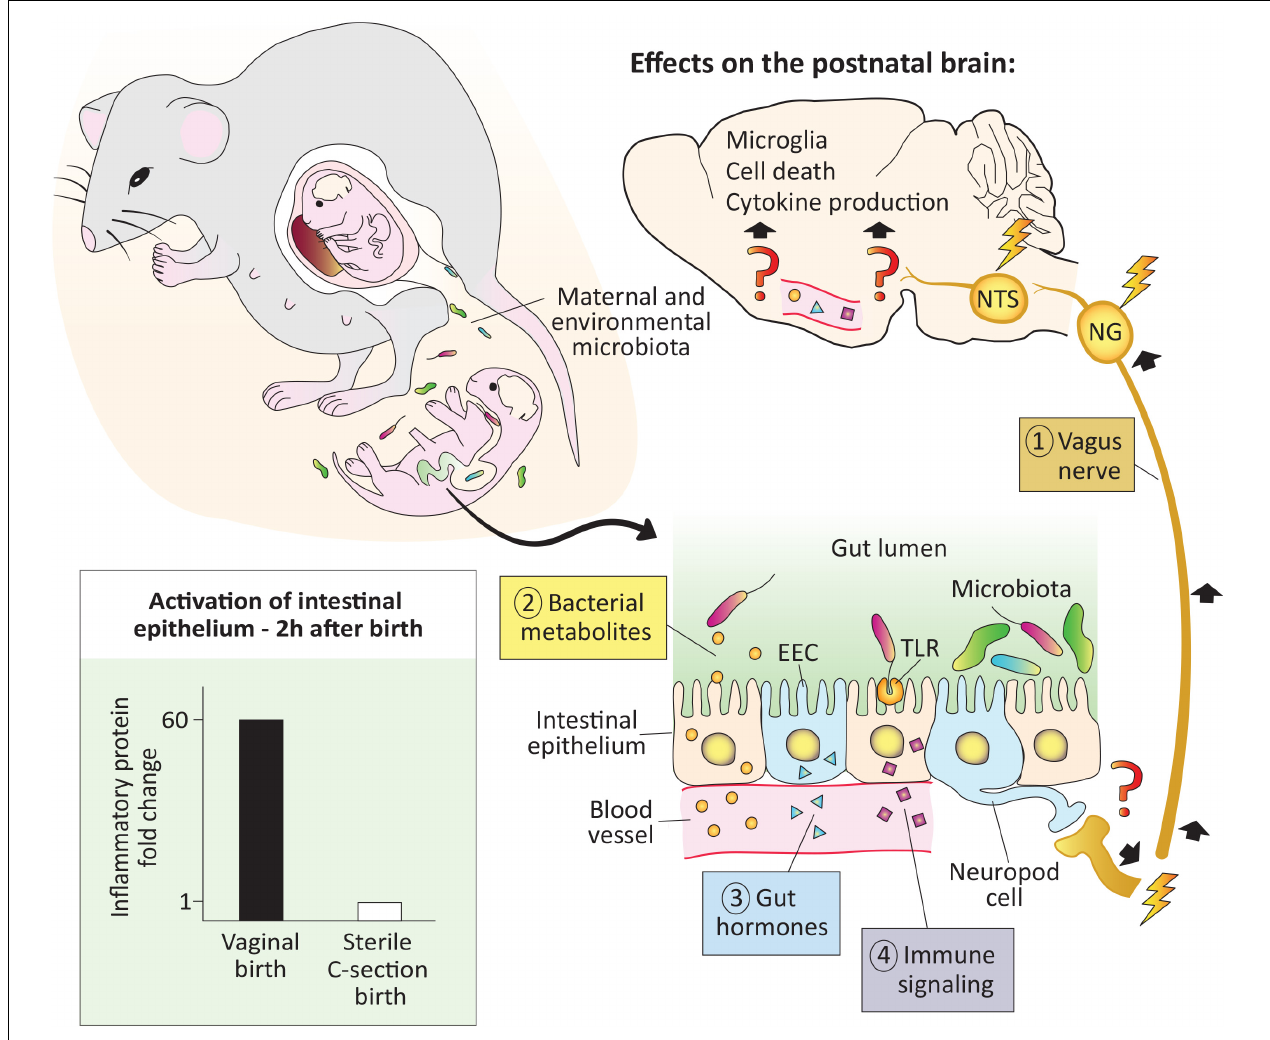
FIGURE 1 | The pioneer microbiota exerts rapid effects on the neonatal brain. At birth the newborn is colonized by maternal and environmental microbiota. In mice, microbial colonization of the gut is associated with activation of the intestinal epithelium (bottom left), as early as 2 h after a vaginal but not a sterile C-section birth (see Lotz et al., 2006). In adults, microbiota signal to the brain via the vagus nerve, bacterial metabolites, gut hormones, and immune signaling, but whether these pathways are functional in the newborn remains to be demonstrated (denoted with question marks). Regardless, effects of microbes on the brain are seen within 12–14 h after birth, and include changes in cell death, microglial cell number and physiology, as well as cytokine expression (top and right; Castillo-Ruiz et al., 2018). EEC, enteroendocrine cell; NG, nodose ganglia; NTS: nucleus of the solitary tract; TLR, toll-like